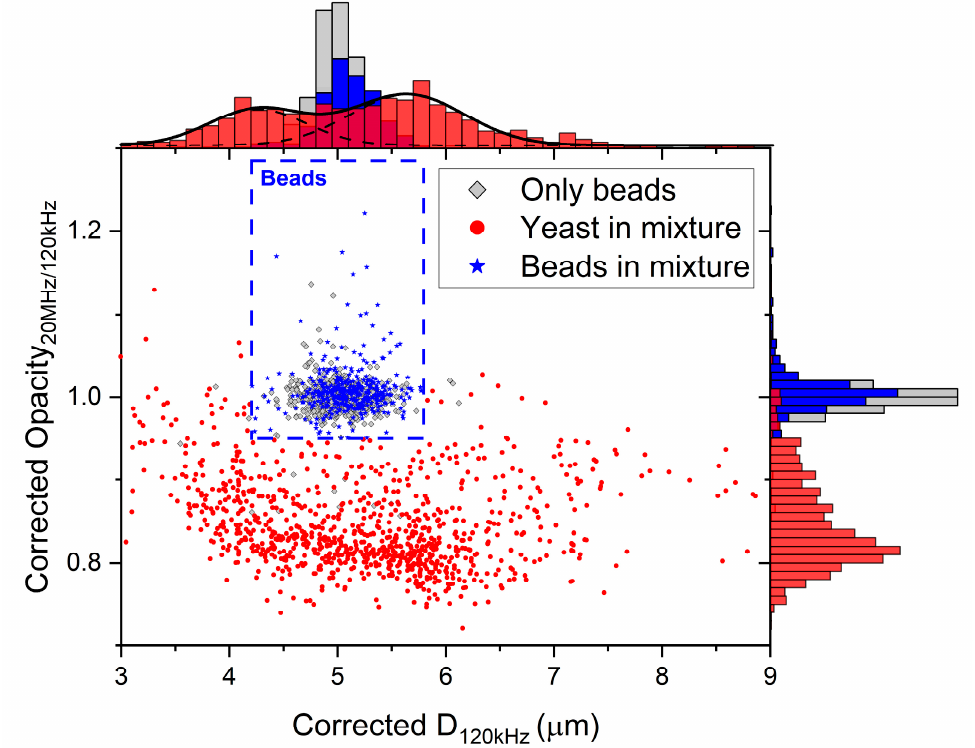
Figure 8. Corrected opacity (Corrected D 20MHz /Corrected D 120kHz ) versus the corrected diameter D at 120 kHz. The beads in the mixture (n = 389) were differentiated from the cells (n = 947) with a threshold (corrected opacity >0.95 and 4.2 µm < corrected D 120kHz < 5.8 µm) comparable to the measurements of only beads (n = 592).